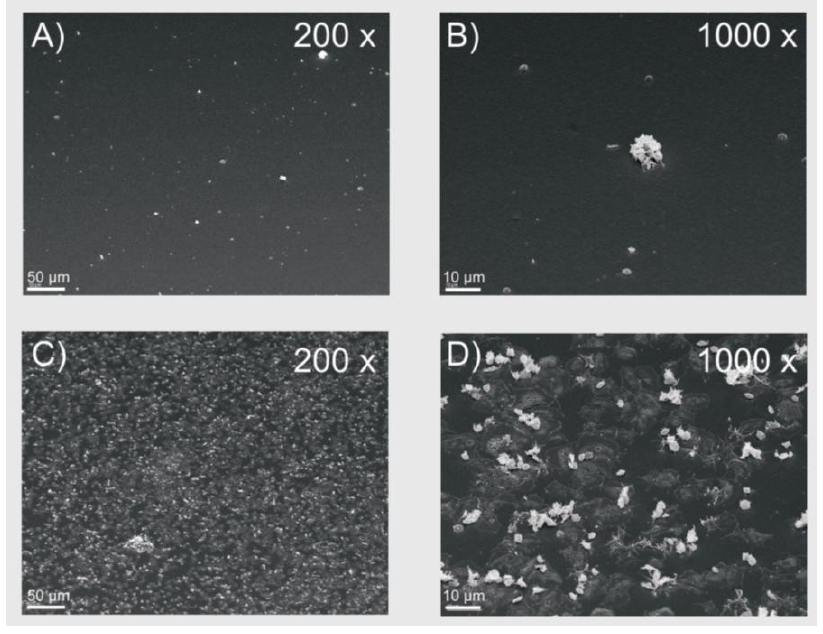
Figure 6. Scanning electron microscopic images of NCO-sP(EO- stat -PO) coated sensors ( A ) and ( B ) and uncoated gold sensors ( C ) and ( D